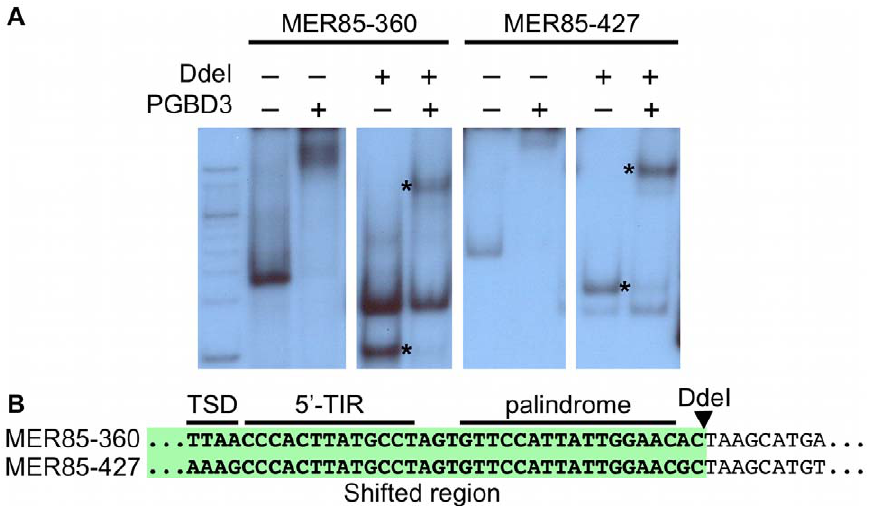
Figure 3. The PGBD3 transposase binds to the 5 9 end of MER85s invitro . (A) An electrophoretic mobility shift assay (EMSA) using MER85s and MER85 DdeI restriction fragments. MER85-360 and MER85-427 were excised from plasmid clones using BamHI and EcoRI, then digested with DdeI or left intact. The restriction fragments were end-labeled and mixed with purified PGBD3 transposase. Restriction fragments derived from the 5 9 end of each MER85 are marked by an asterisk. (B) Partial sequences of MER85-360 and MER85-427 with the DdeI restriction site indicated. The 5 9 MER85 sequences that shifted upon incubation with transposase are highlighted in green. TSD, target site duplication; 5 9 -TIR, 5 9 terminal inverted repeat.